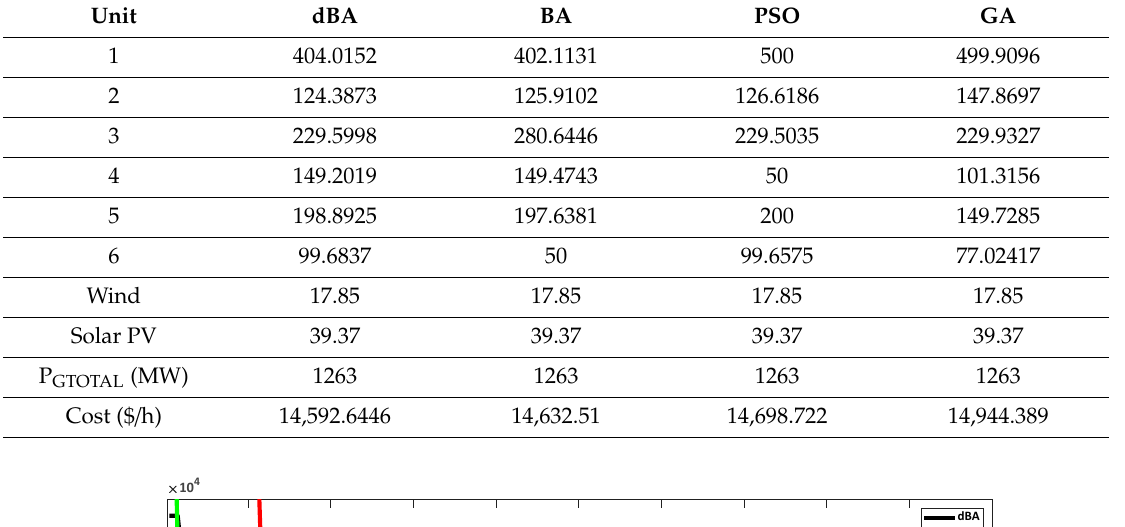
Table 20. Comparison of the dBA, BA, PSO, and GA with renewables.